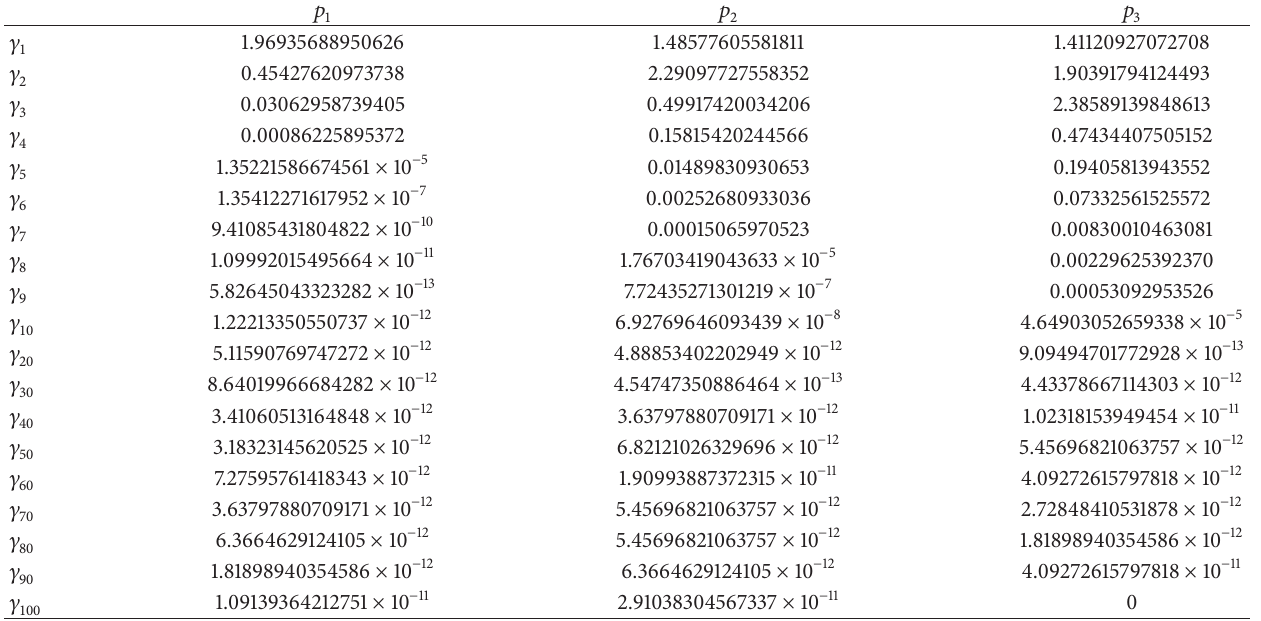
Table 5: Approximation of the lengths of the